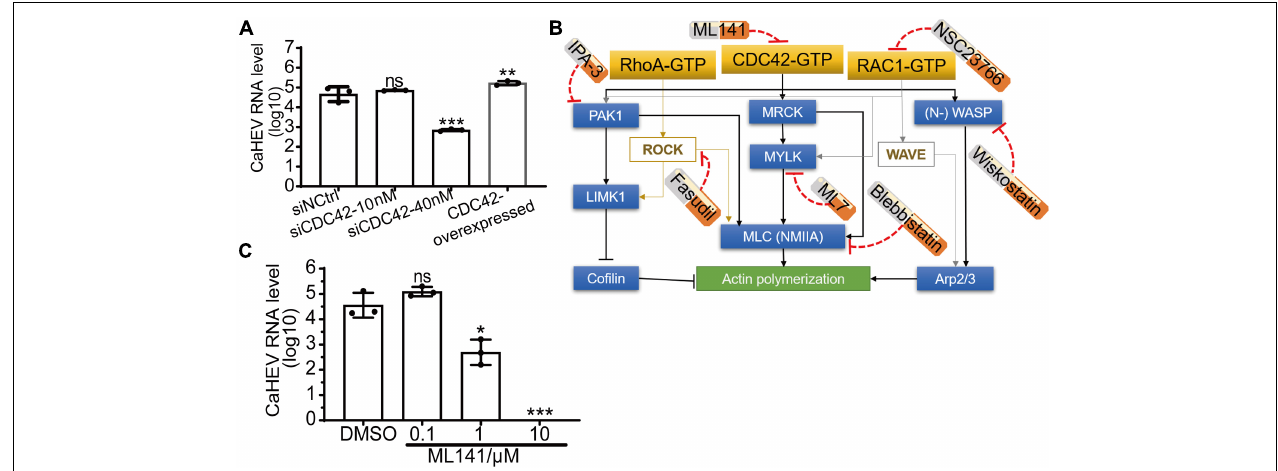
FIGURE 3 | Positive correlation between expression level and activity of CDC42 and avian HEV infection in host cells. (A) Copies of CaHEV RNA in CDC42-overexpressed and -knocked down LMH OATP1A2 cells after inoculated with CaHEV at 7 dpi. (B) Schematic diagrams of different small molecular inhibitors for Rho family GTPases. ML141 is a selective, reversible non-competitive inhibitor of CDC42, preventing GTP binding to the active site of CDC42 without targeting any CDC42-regulating molecules. Fasudil is a non-specific RhoA-associated kinase (ROCK) inhibitor. NSC23766 is an inhibitor of RAC1 activation. IPA-3 is a downstream CDC42 signaling inhibitor, selectively inhibiting group 1 PAKs by targeting the auto-regulatory mechanism. ML7 potently inhibits myosin light chain kinase (MLCK). Blebbistatin is a selective non-muscle myosin IIA (NMIIA) inhibitor. Wiskostatin is a selective neural Wiskott-Aldrich syndrome protein (N-WASP) inhibitor by binding GTPase binding domain to prevent activation of the actin-polymerizing protein Arp2/3. MRCK, myotonic dystrophy kinase-related Cdc42-binding kinases. (C) Detection of CaHEV ORF3 RNA in the LMH OATP1A2 cells treated with ML141 by qPCR. ns, no significant; * P < 0.05; ** P < 0.01; *** P < 0.001.